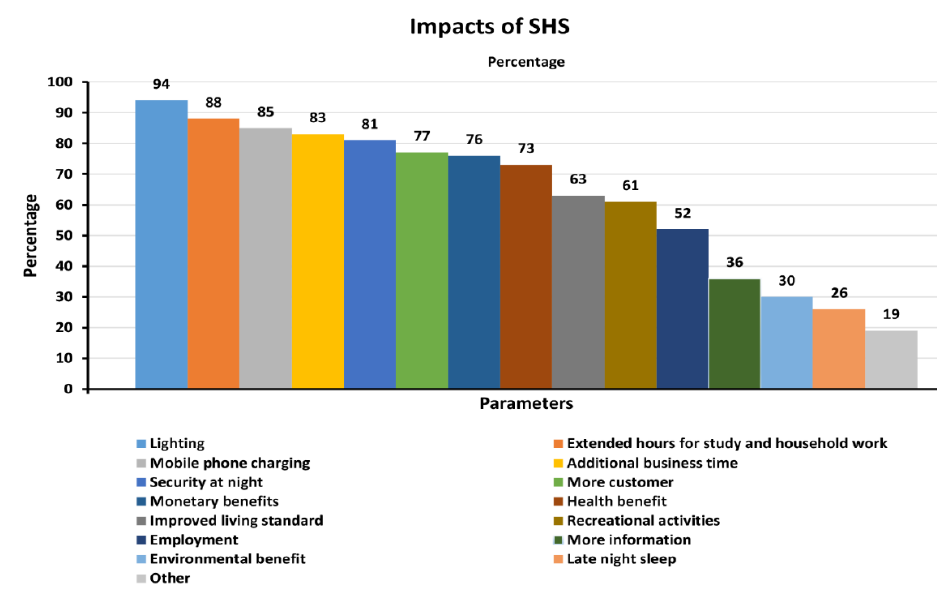
Figure 2. Socio-economic impacts of solar home systems.